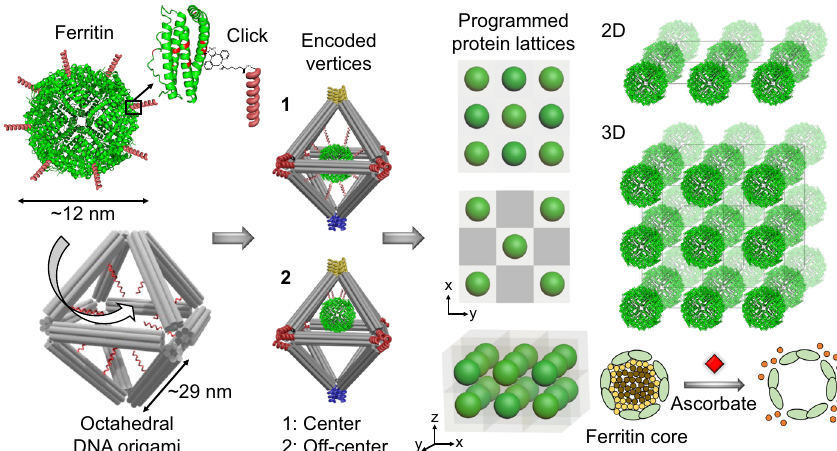
Fig. 1 The concept of programmable assembly of bio-active 2D and 3D protein arrays by integrating ferritin with DNA frames (octahedra, Octa) into protein voxels. A high-yield stable frame-encapsulation of ferritin and apoferritin into protein voxels and their assembly into ordered arrays through a stepwise modi fi cation of protein (ferritin, PDB ID: 1IER) surfaces (at the lysine residues (red)). A targeted placement of proteins, encoded with DNA sequences, at the frame ’ s center (1) and shifted toward a vertex (2). Various positions of the encapsulated ferritin (see “ Methods ” section and Supplementary Fig. 7 for design in detail) inside the frame can be prescribed, as discussed later in the text. The designed 2D single- and double-layered, and 3D ferritin and apoferritin lattices were formed by establishing prescribed vertex-to-vertex Watson – Crick interconnections. The 3D ordered ferritin array could be converted into a coreless apoferritin array with preserved structure using ascorbate to reduce and release iron ions (orange circles) from ferritin.